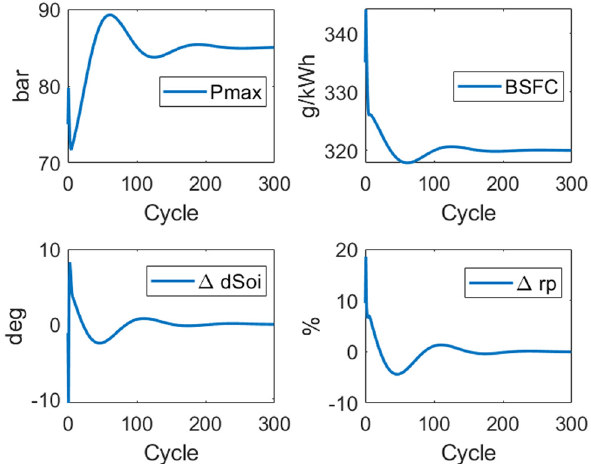
Figure 4: Simulation